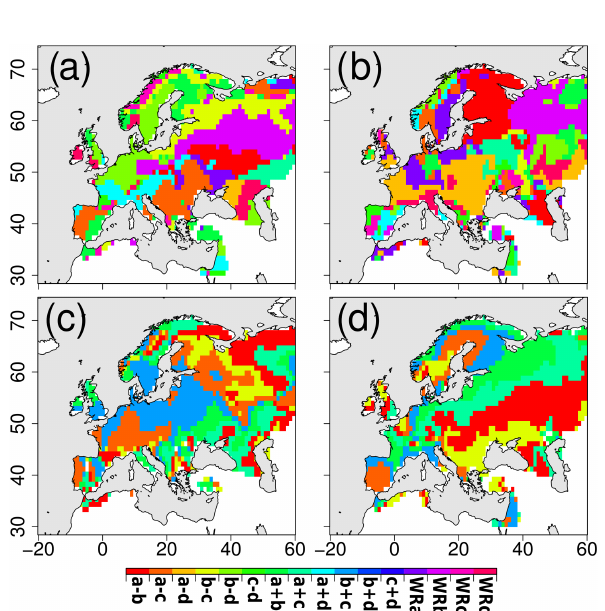
Figure 1. Automatic attribution of the best predictors in winter (a) , spring (b) , summer (c) and autumn (d) based on the occurrence anomalies of WRs of ERAI and the observed precipitation (used for the operational and idealized forecasts). The names of the pre- dictors are indicated on the colour scale.